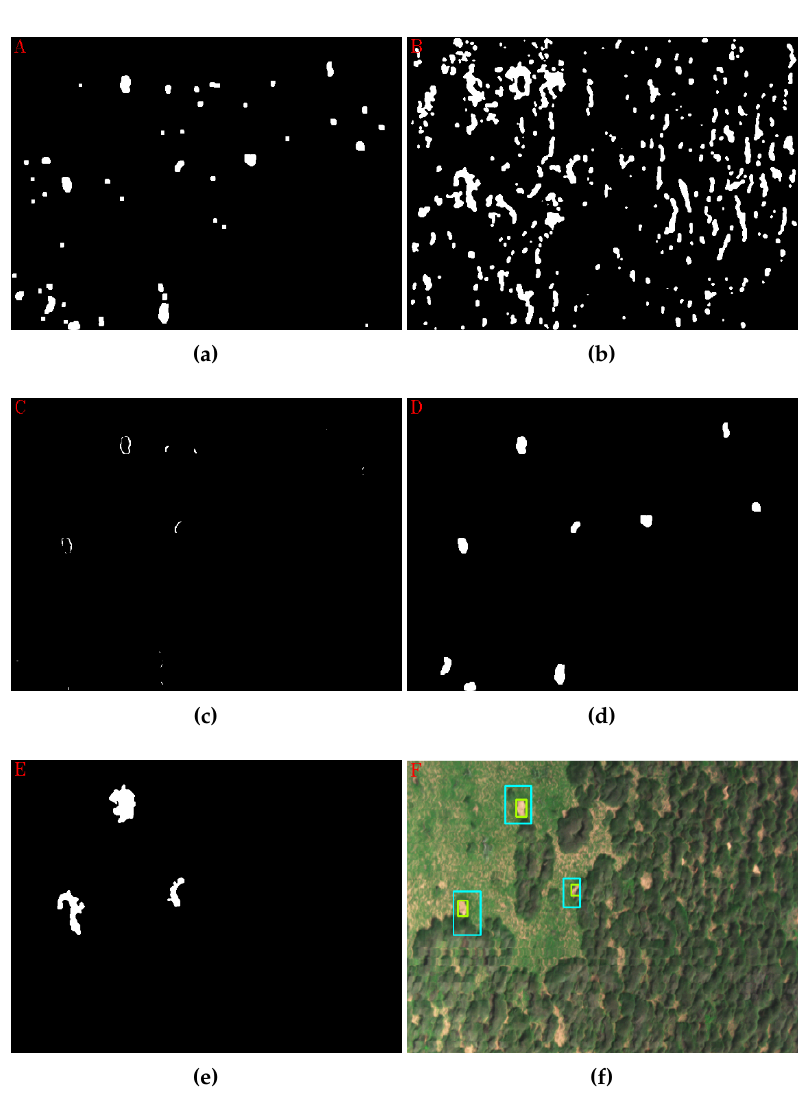
Figure 10. Main stages of the segmentation process. ( a ) Binary soil layer. ( b ) Binary grass layer. ( c ) AND logic operator between ( a ) and ( b ). ( d ) Filtered soil contours. ( e ) Filtered grass contours. ( f ) Identified contours in the ROI.